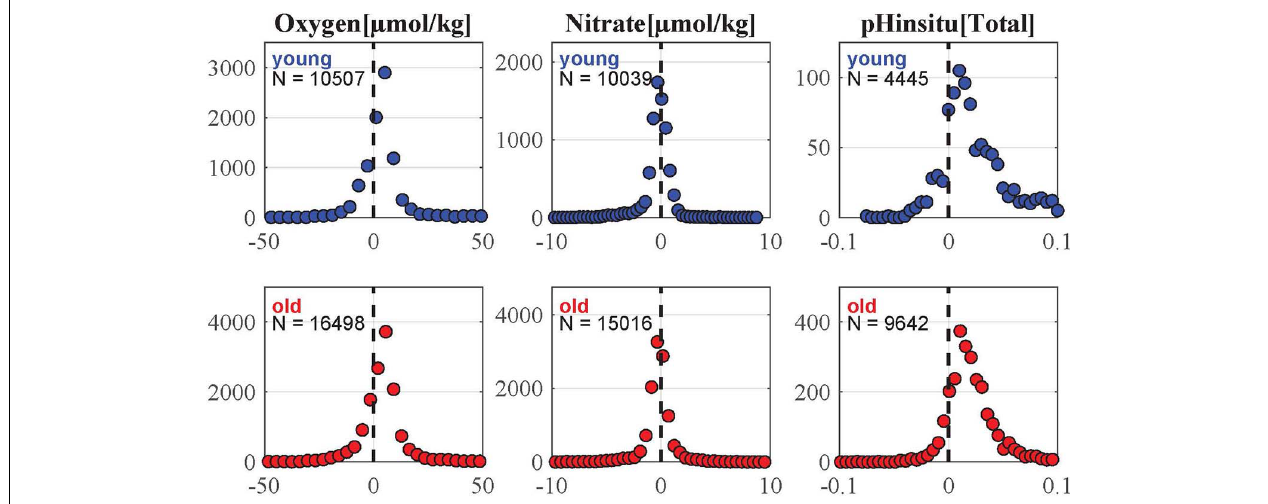
FIGURE 14 | Histograms of GLODAPv2 minus quality-controlled oxygen (left) , nitrate (center) , and pH (right) float data. Upper panels include data from floats between 6 months and 2 years of age; lower panels include data from floats older than 2 years of age. Matchups were restricted to data that was within 20 km of GLODAPv2 reference